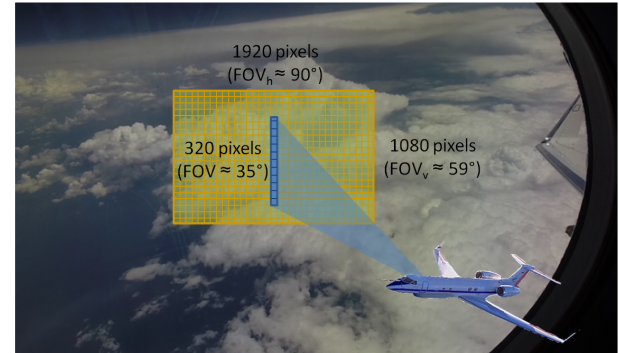
Figure 2. Schematics of cloud-side observations by the imaging spectrometer specMACS (SWIR camera) and the GoPro camera. The individual fields of view (FOVs) and corresponding number of spatial pixels are